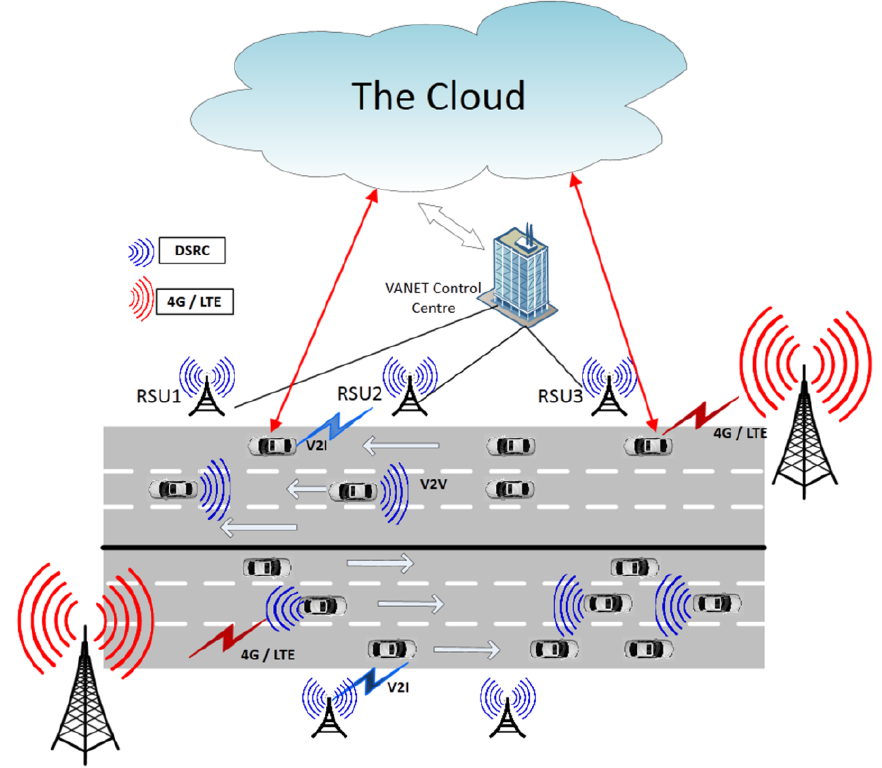
Figure 1. Vehicular Internet